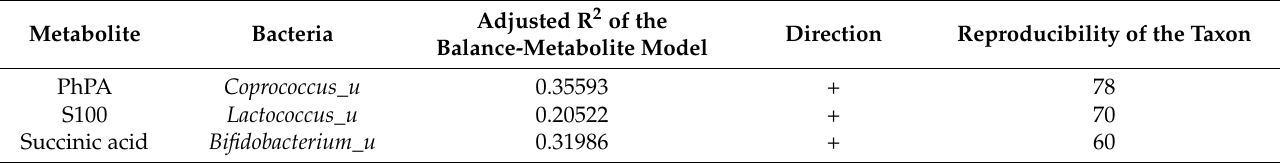
Table 3. Reliable associations (the reproducibility of bacterial taxa > 50% and R 2 > 0.2) between the metabolites levels and bacteria abundances identified using the balances-based approach (“+” direction denotes numerator and “-” direction-denominator). Adjusted R 2 of the Metabolite Bacteria Reproducibility of the Taxon Balance-Metabolite Model